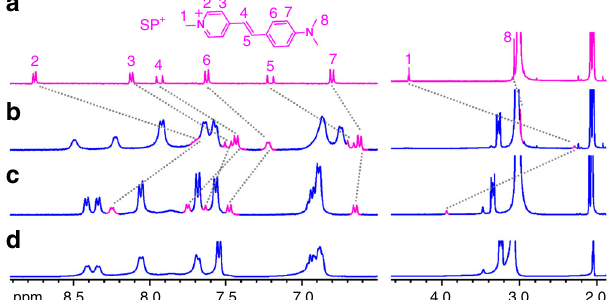
Fig. 6 Displacement binding of SP + by Ch + . a 1 H NMR (400 MHz, acetone- d • I (inset shows the structure), b host 6 /1.5% H 2 O) spectra of a 1 mM SP 2 /SP • I (1/1 equiv.), c host 2 /SP • I/Ch • Cl (1/1/1 equiv.), and d host 2 / Ch • Cl (1/1 equiv.). Chemical shifts of protons of SP + upon complexation and decomplexation were labeled by gray